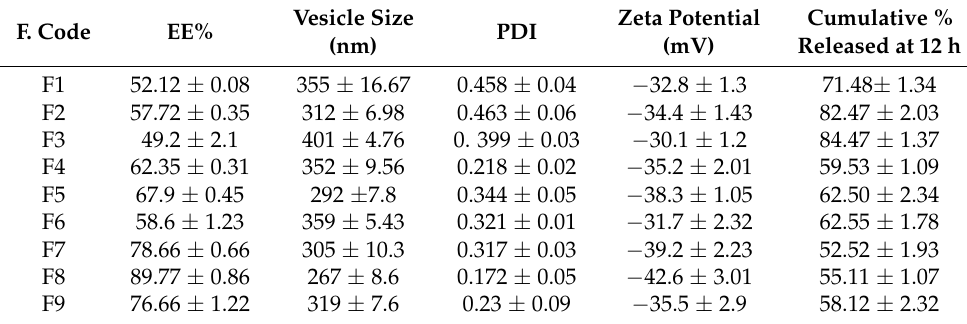
Table 2. Different dependent formulation parameters of LUT-ENPs.